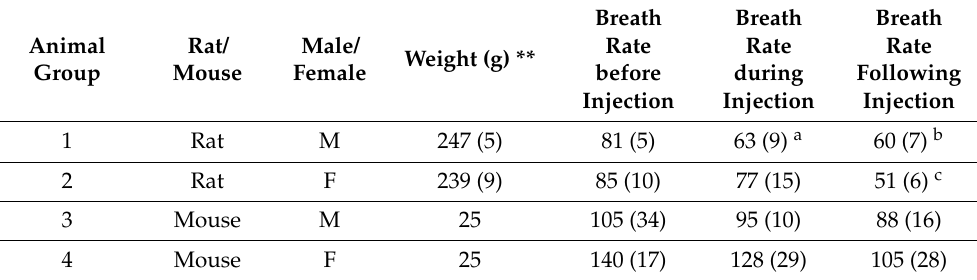
Table 1. Averaged data—animal weight and breath rate before, during, and following a sodium nitrate injection *, under anesthesia.